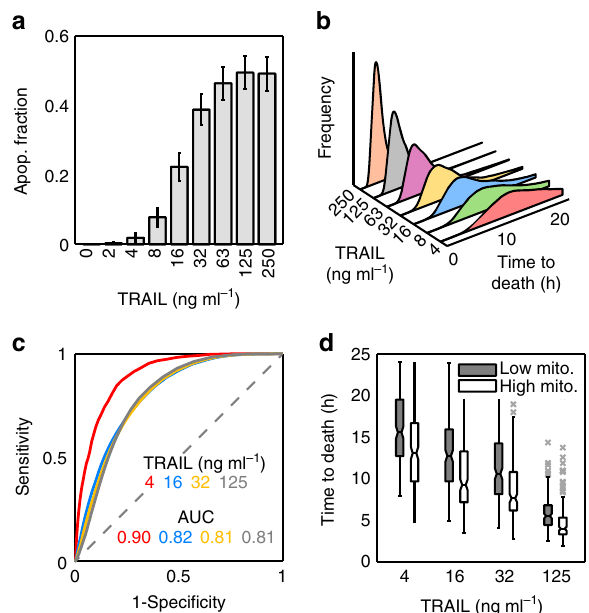
Fig. 5 Coupling protein variability to mitochondrial mass is enough to explain apoptosis outcome. a Fraction of simulated apoptotic cells after 24 h of treatment with TRAIL at the indicated doses. Error bars are computed by bootstrapping. b Distributions of apoptosis times at different TRAIL doses from model simulations. c Analysis of mitochondrial content as a binary classi fi er (death/life) of cell fate from model simulations. d Boxplots of time to death for simulated HeLa cells with mitochondrial levels in the fi rst quartile (Low mito, grey) and in the fourth quartile (High mito, white) at different doses of TRAIL. Each dose was simulated with an ensemble of 10,000 cells. Boxes cover the range from the lower to the upper quartile of the data. Whiskers indicate maximum and minimum values, excluding outliers which are plotted as individual grey crosses. Horizontal lines inside the boxes represent median values, and notches indicate 95% con fi dence intervals for the Bax/Bcl-2, while its in fl uence on other nodes of the apoptotic pathway may not be so relevant.